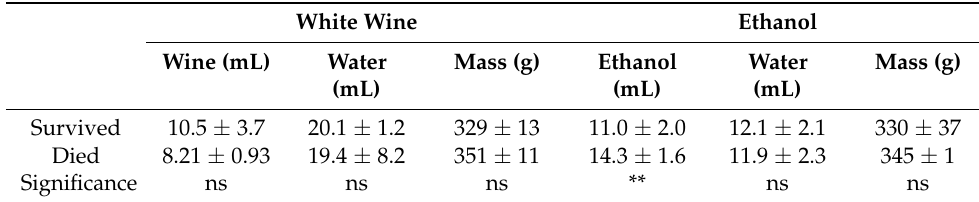
Table 2. Intake of white wine, ethanol and water based on the outcome after MI. The last row contains p -values for tests of differences between the corresponding measurements within the same treatment group. The results are presented as mean ± SD. A p -value smaller than 0.05 was considered statistically significant. ns = not significant. ** denotes a p -value between 0.001 and 0.01. White Wine Ethanol White wine Ethanol Wine (mL)